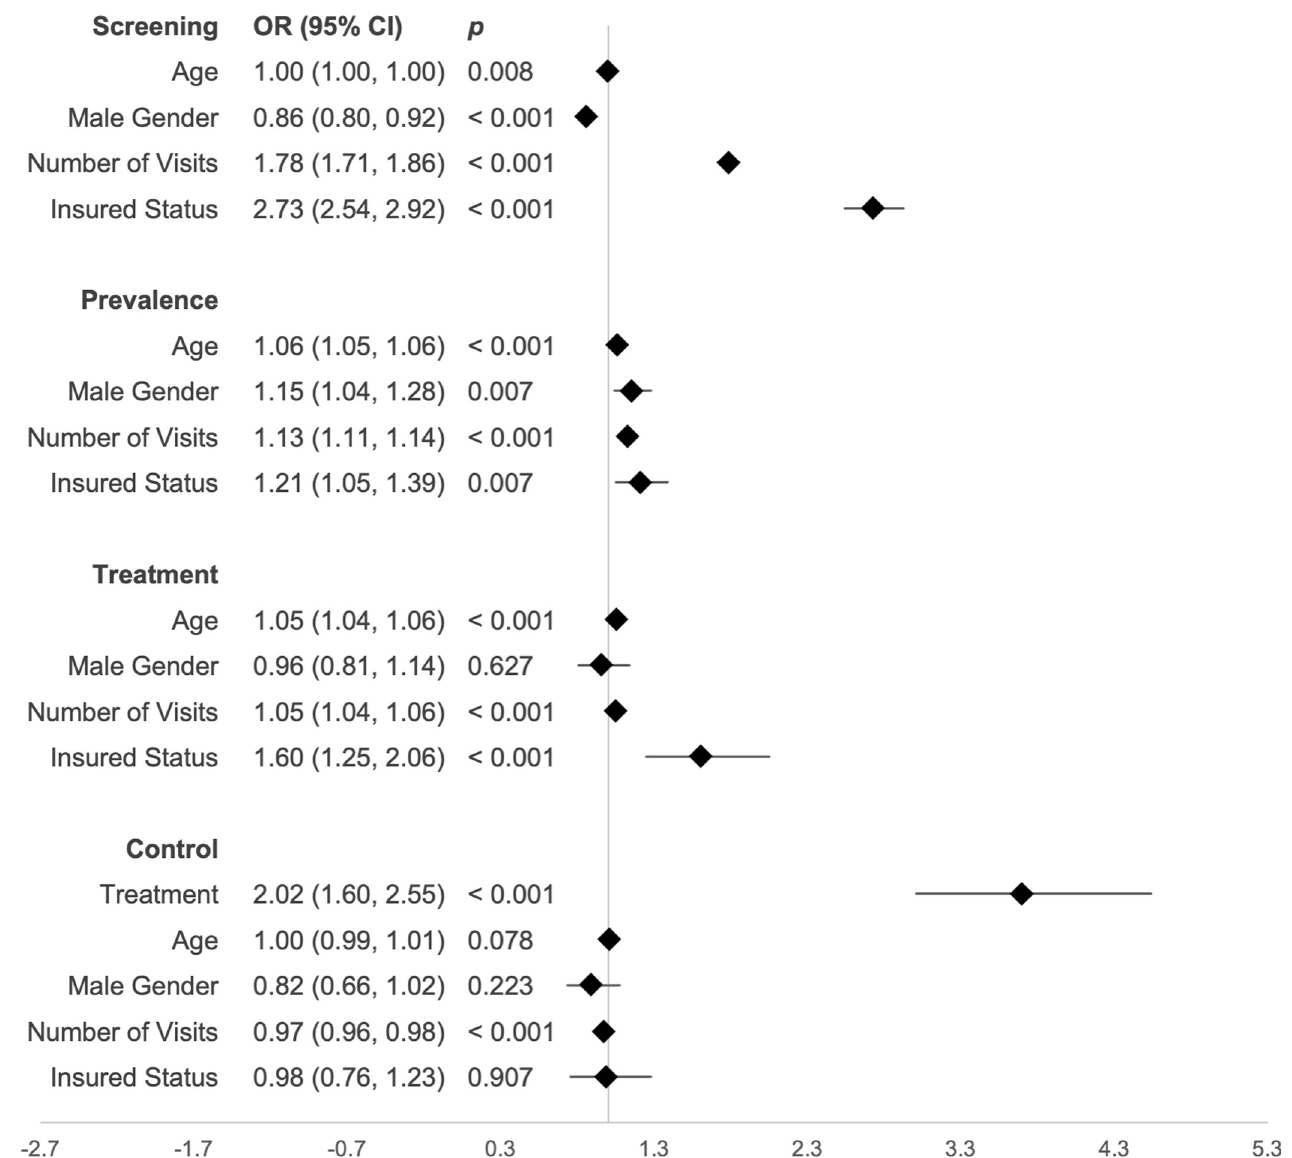
Fig 3. Multiple logistic regressions. Each multivariate logistic regression model predicts the likelihood of an individual being screened for hypertension, having hypertension, treated for hypertension, or controlled.